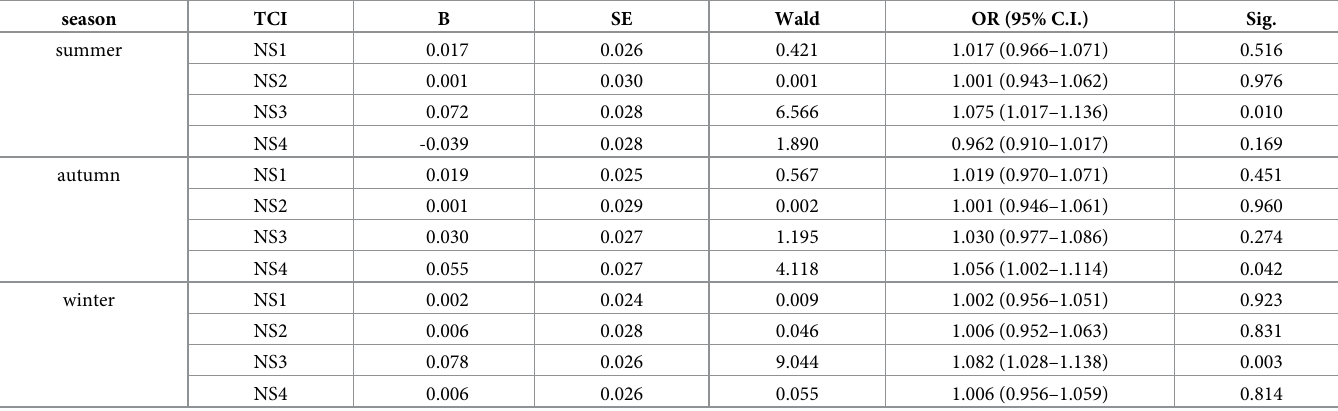
Table 3. Multinomial logistic regression analysis of NS subscales on season of birth among